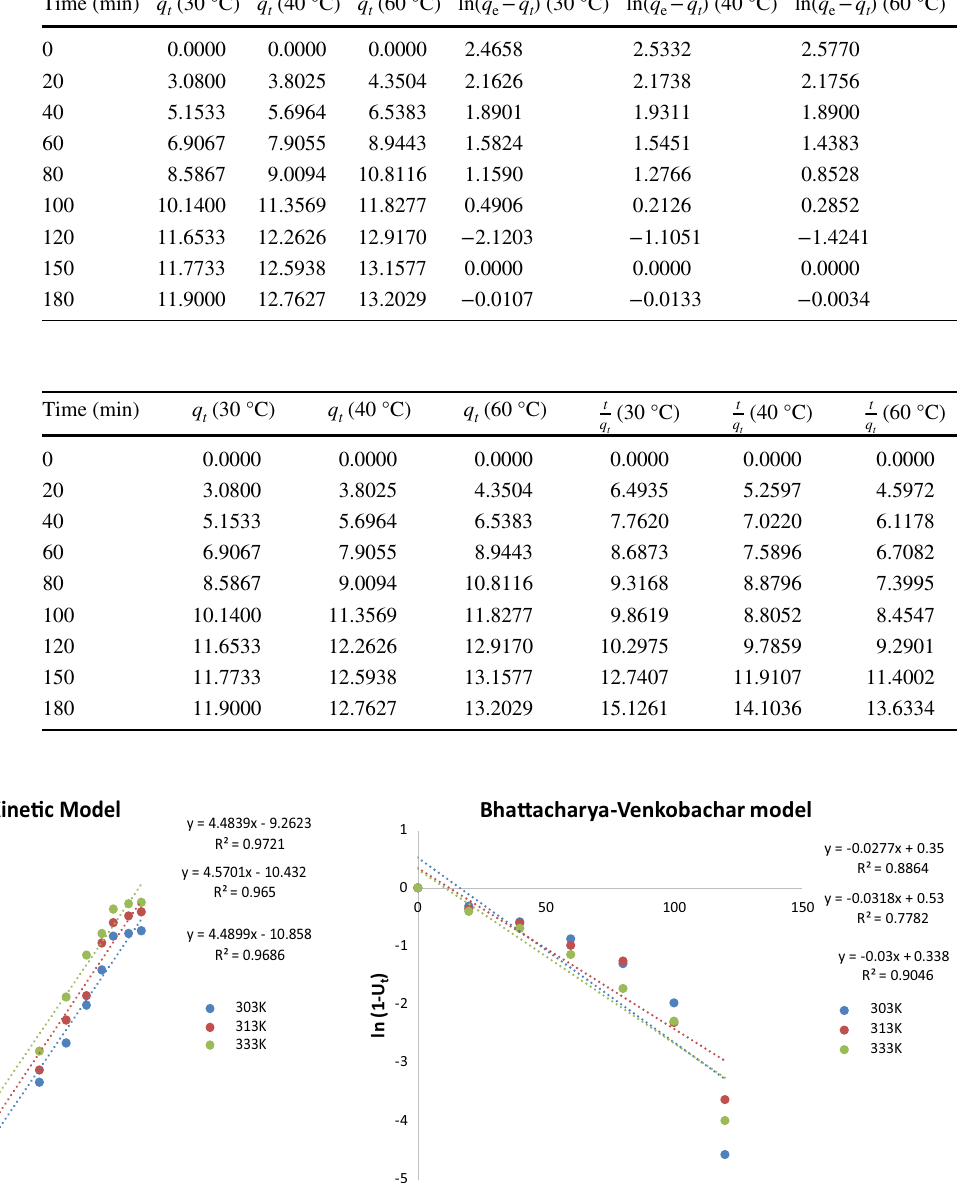
Table 5 Pseudo-first-order values for different temperature conditions